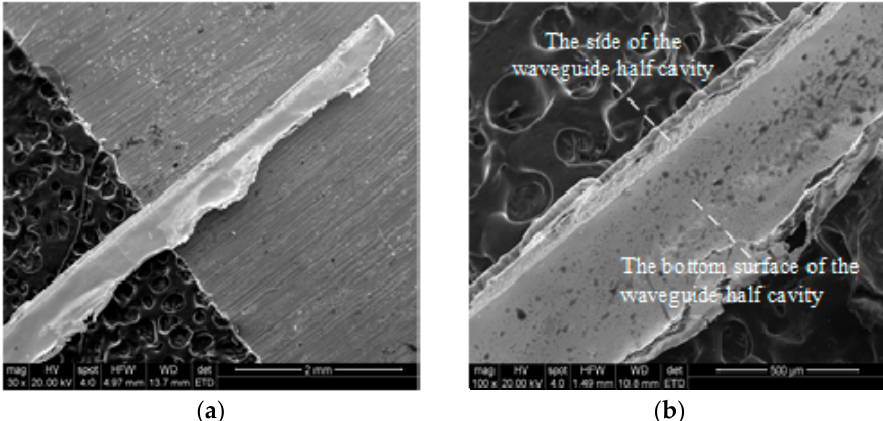
Figure 14. SEM examples of the open-type waveguide half-cavity: ( a ) integral topography, ( b ) local topography.